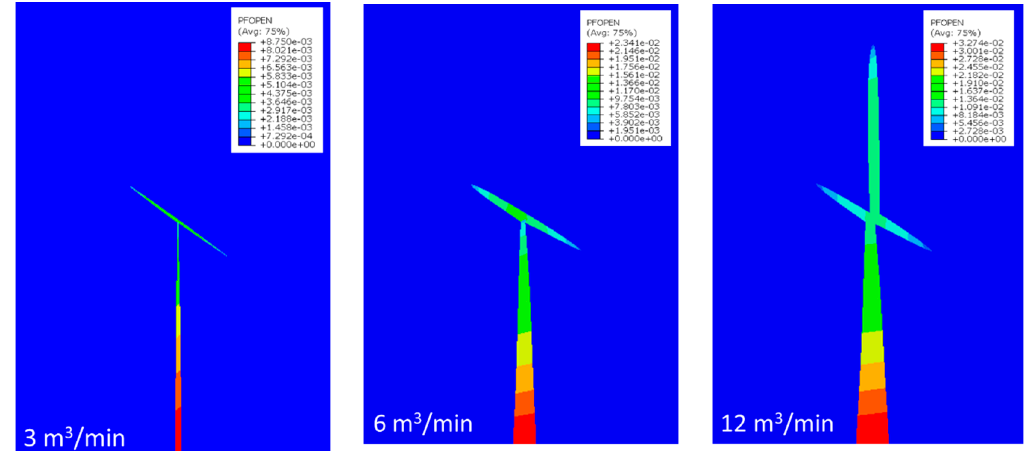
Figure 8. Crack geometry in different fracturing fluid injection rate.